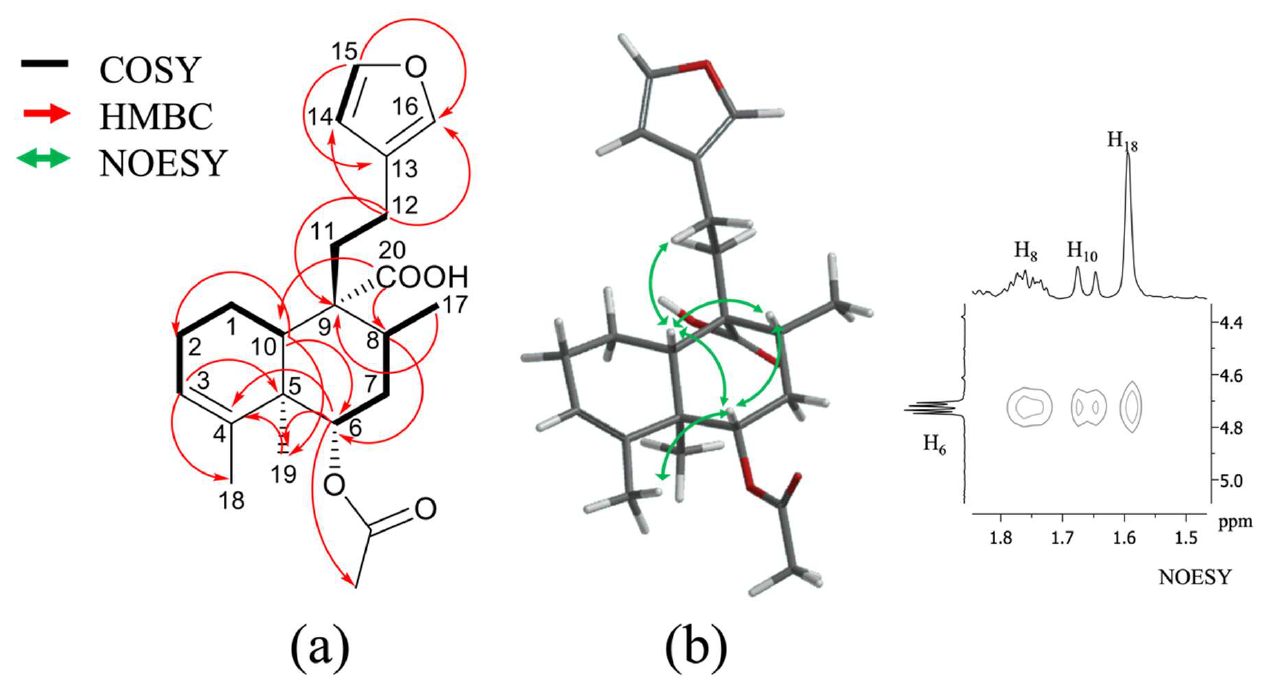
Figure 2. ( a ) 1 H- 1 H COSY and key HMBC (H—C) correlations of compound 2 ; ( b ) Key NOESY correlations of compound 2 .